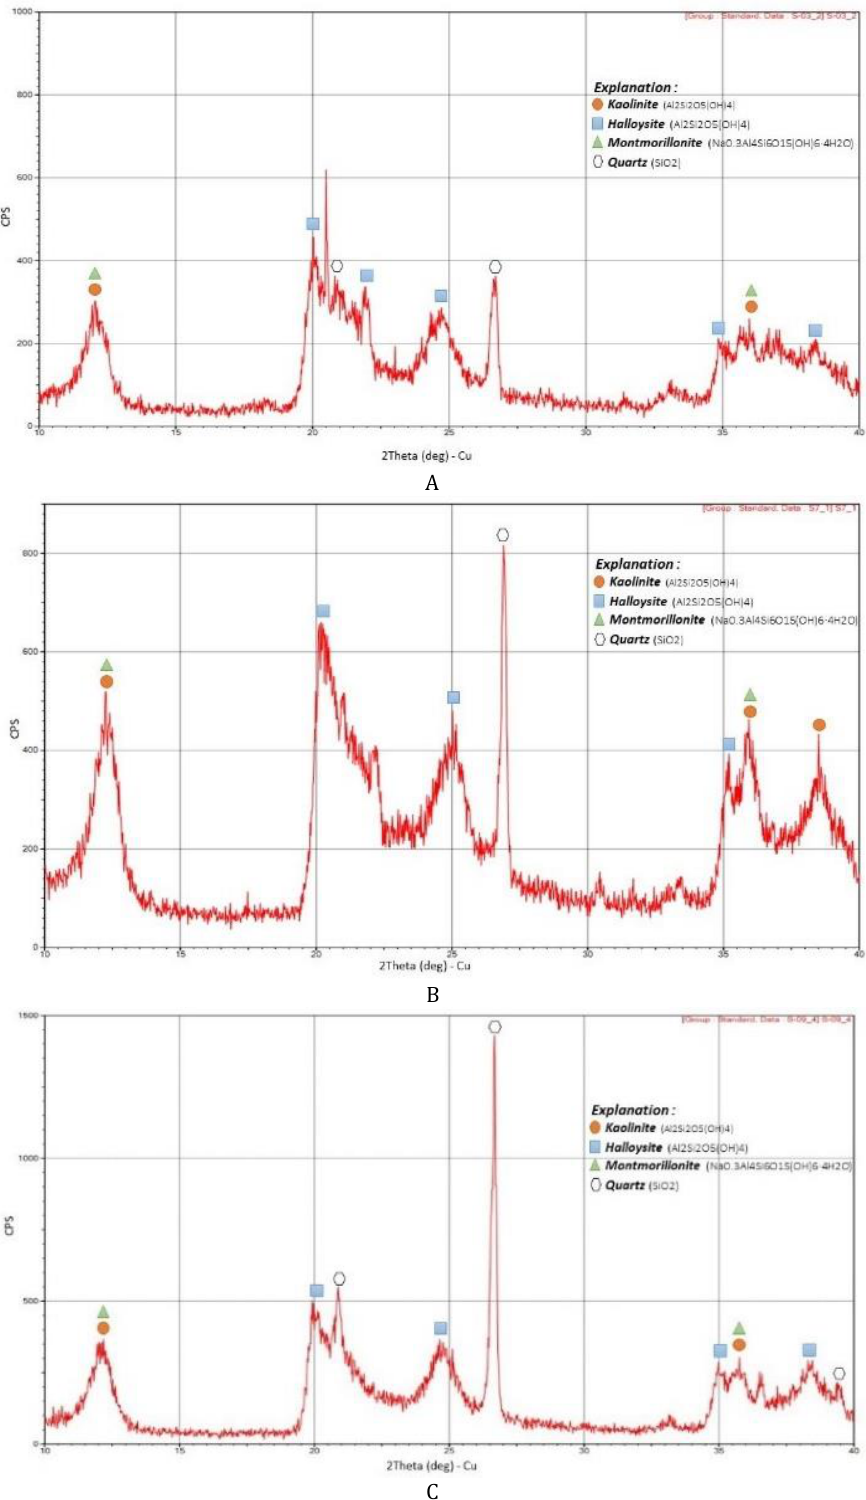
Fig. 4. Typical of XRD diffractogram on A. S3; B. S7; and C.